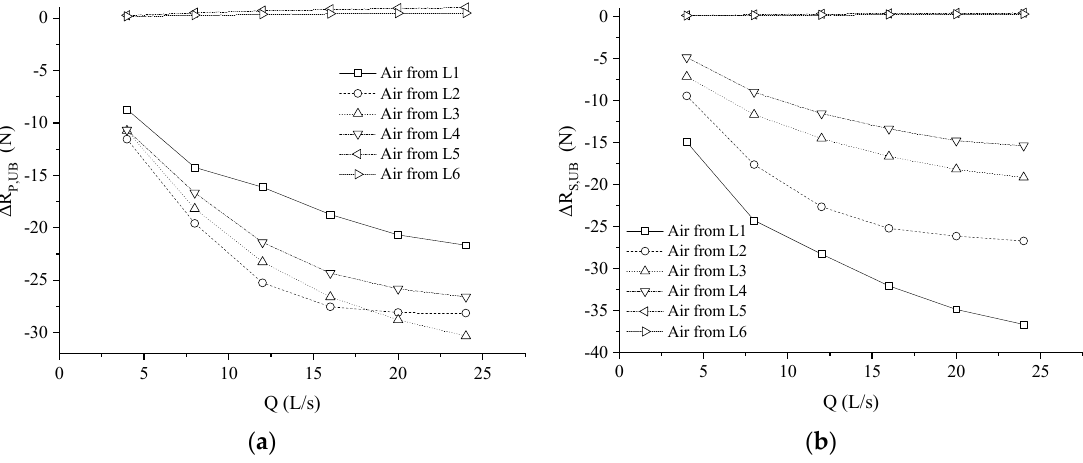
Figure 14. Changes in the resistance component of the underwater body: ( a ) Component related to the pressure force; ( b ) Component related to the shear